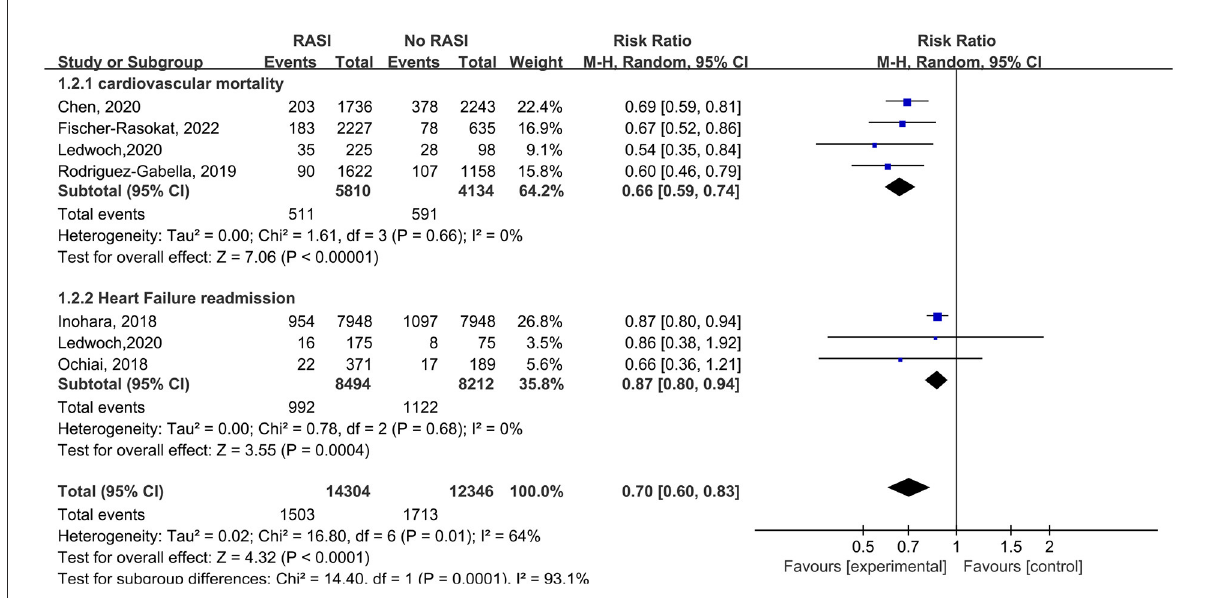
FIGURE3 Forest plots of random-effects meta-analysis for the rates of cardiovascular death and heart failure readmission.